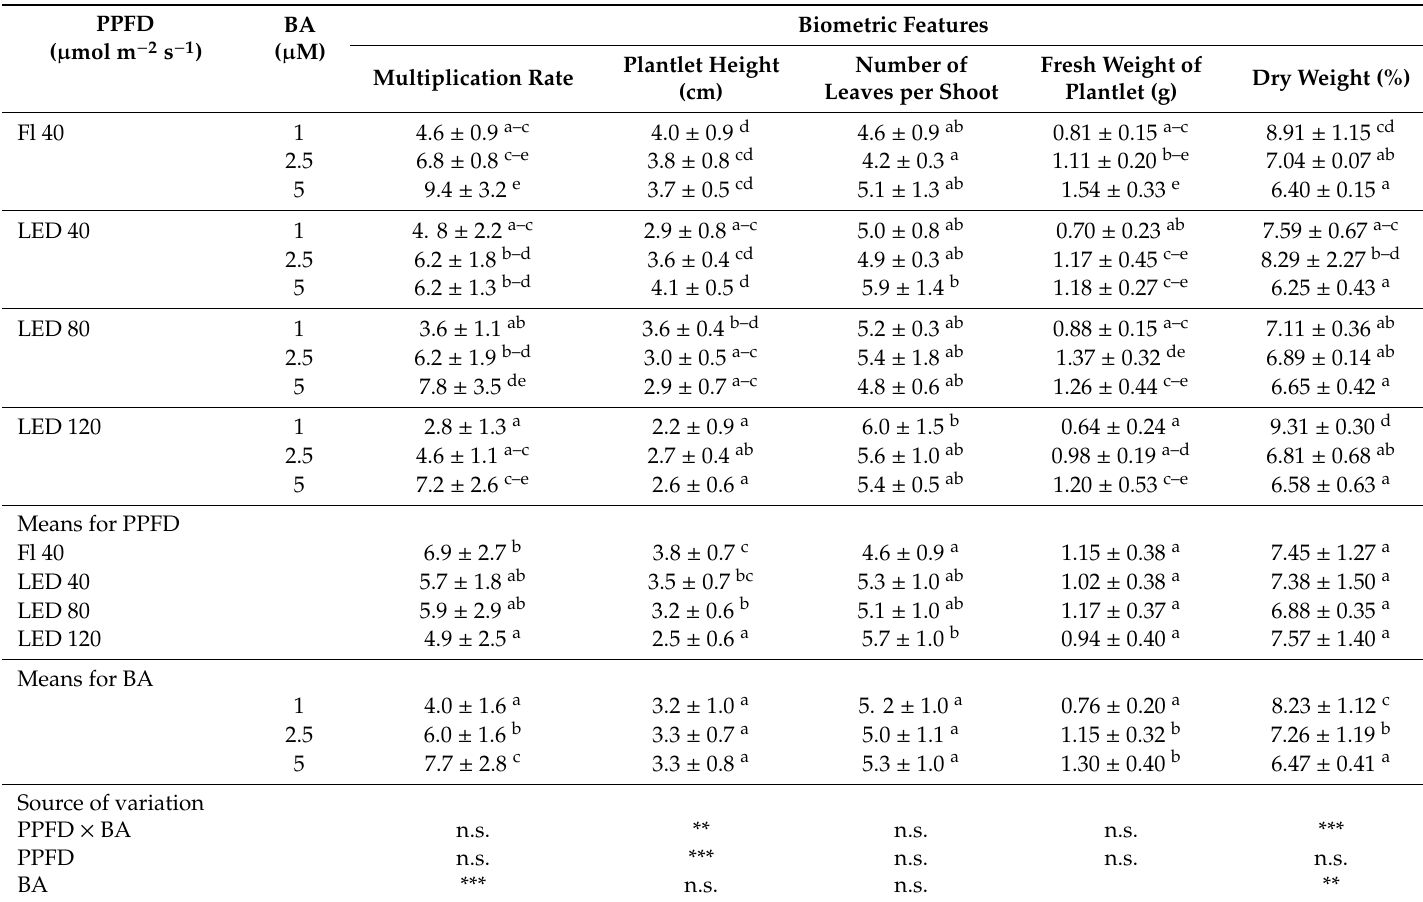
Table 1. Biometrical properties of growth and fresh and dry weight of Gerbera jamesonii after six weeks of in vitro culture on Murashige and Skoog (MS) medium with various 6-benzyladenine (BA) concentrations and di ff erent photosynthetic photon flux densities PPFDs. Significant e ff ect: **, p ≤ 0.05; ***, p ≤ 0.01; n.s.—not significant. Fl 40—control, fluorescence Philips TK-D 36W / 54 lamps. LED 40, LED 80, LED 120—combination of red (70%) and blue (30%) light emitted by light-emitting diodes with 40, 80, and 120 µ mol m − 2 s − 1 PPFD, respectively. Means ± standard deviations within a column followed by the same letter are not significantly di ff erent according to Duncan’s multiple range test at p ≤